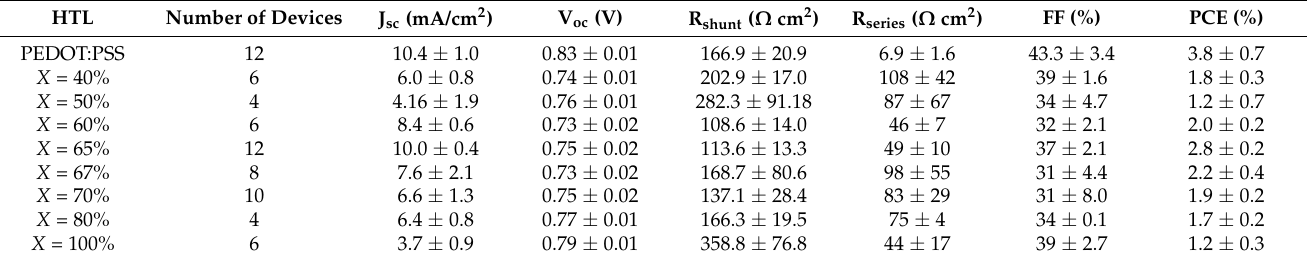
Table 1. Average and standard deviation of the photovoltaic parameters for the different OSCs under 1 sun illumination (AM 1.5G, 100 mW/cm 2 ). Reported information are the cationic ratio in the initial solution ( X ), number of tested devices, short-circuit current density (J sc ), open-circuit voltage (V oc ), Fill factor (FF), shunt resistance (R shunt ), series resistance (R series ), and power conversion efficiency (PCE) values of the OSCs for each tested HTL.